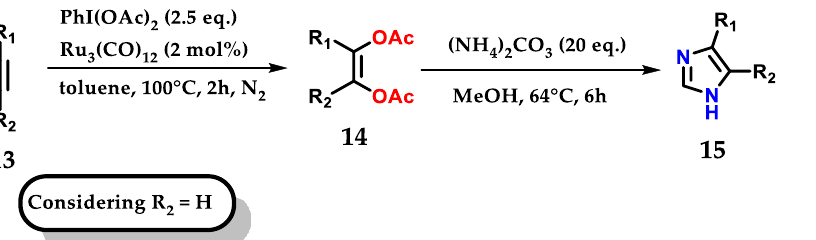
Figure 11. Ruthenium-catalyzed oxidation of alkynes for mono-substituted imidazole 15 synthesis.